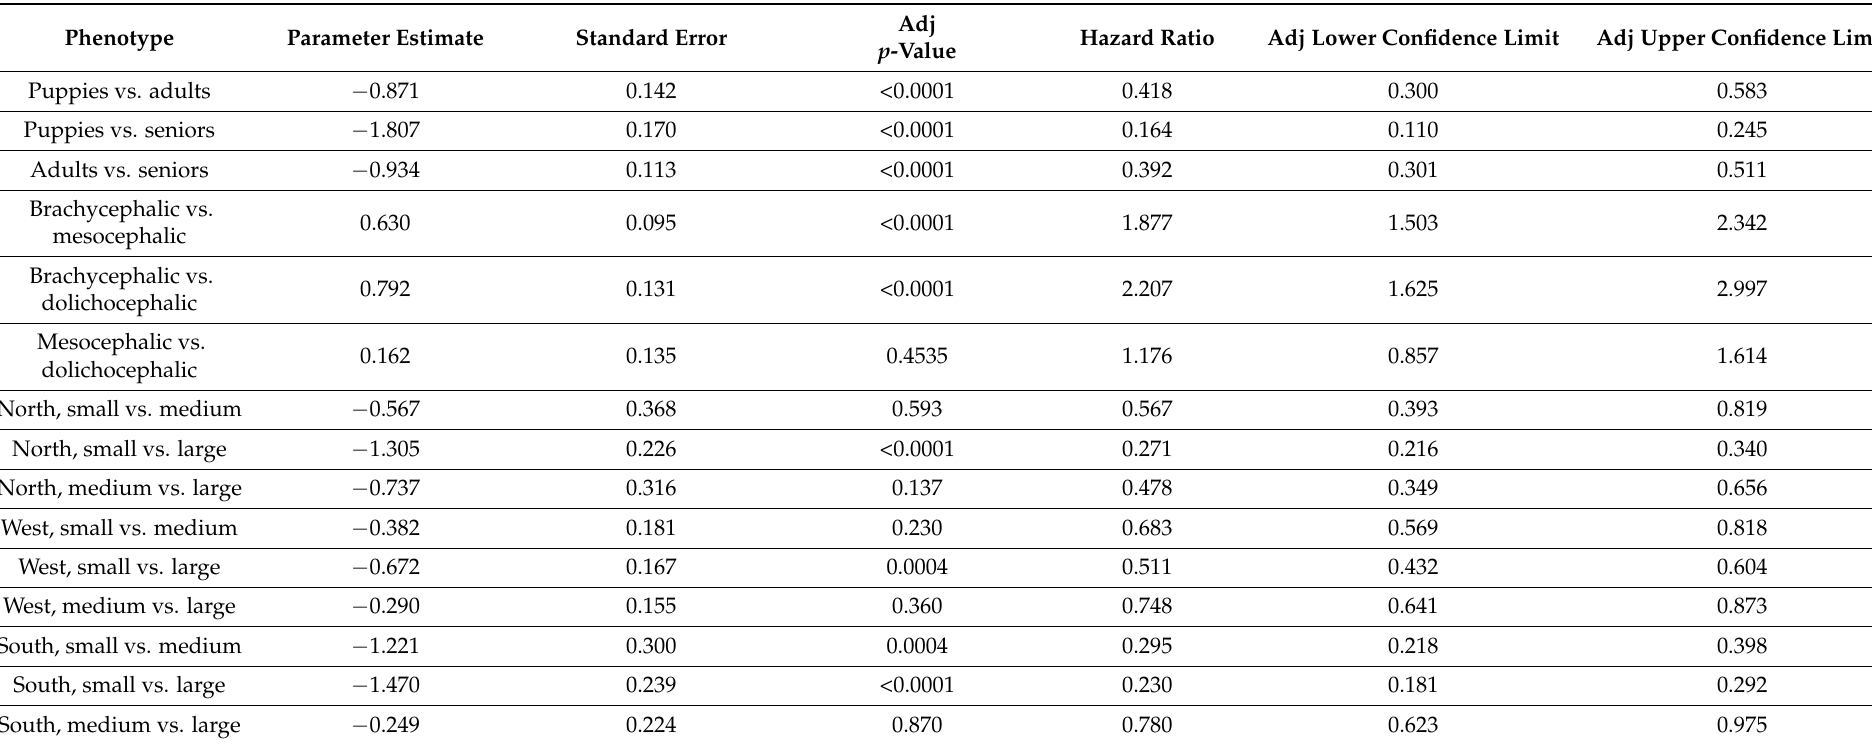
Table 2. Extended Cox regression model for euthanasia using the simple random sample of 6200 dogs. Adjustment for multiple comparisons was performed using Tukey–Kramer